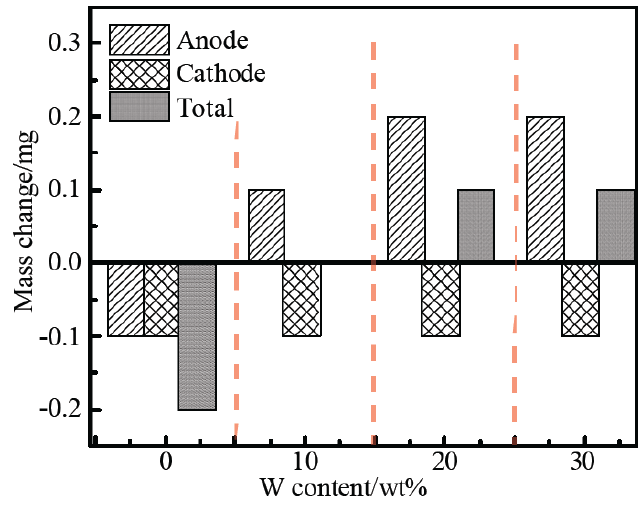
Figure 11. Quality change in Cu-W composite contacts with different W contents.